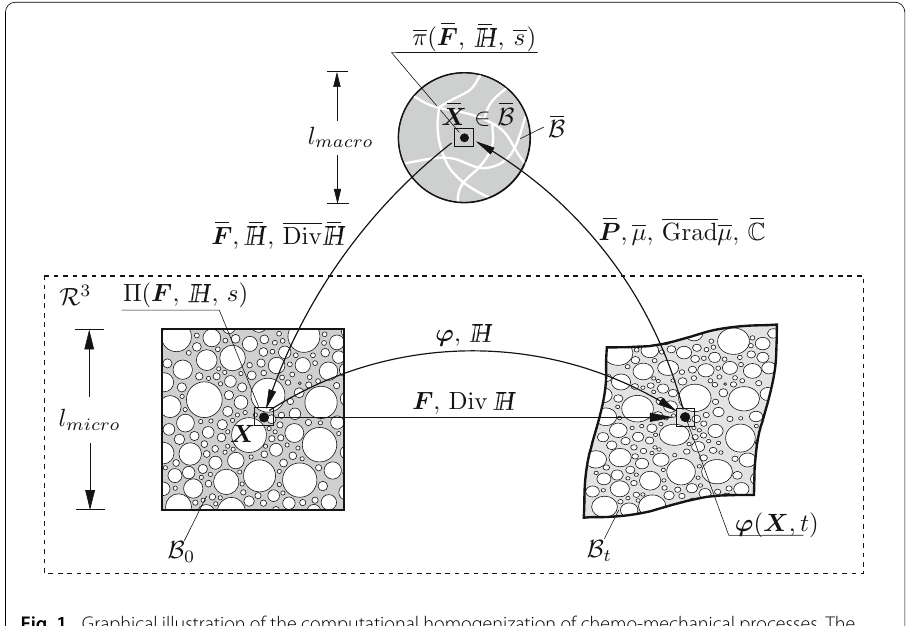
Fig. 1 Graphical illustration of the computational homogenization of chemo-mechanical processes. The macroscopic dual fields and moduli at a macroscopic material point X are determined by solving a microscopic boundary value problem. The domain of the microscopic problem is chosen such that it represents the heterogeneity of the microstructure in a representative manner and is thus referred to as representative volume element (RVE). In a minimization-based variational formulation the RVE is driven by the deformation gradient F as well as the solvent-volume flux H and its divergence Div